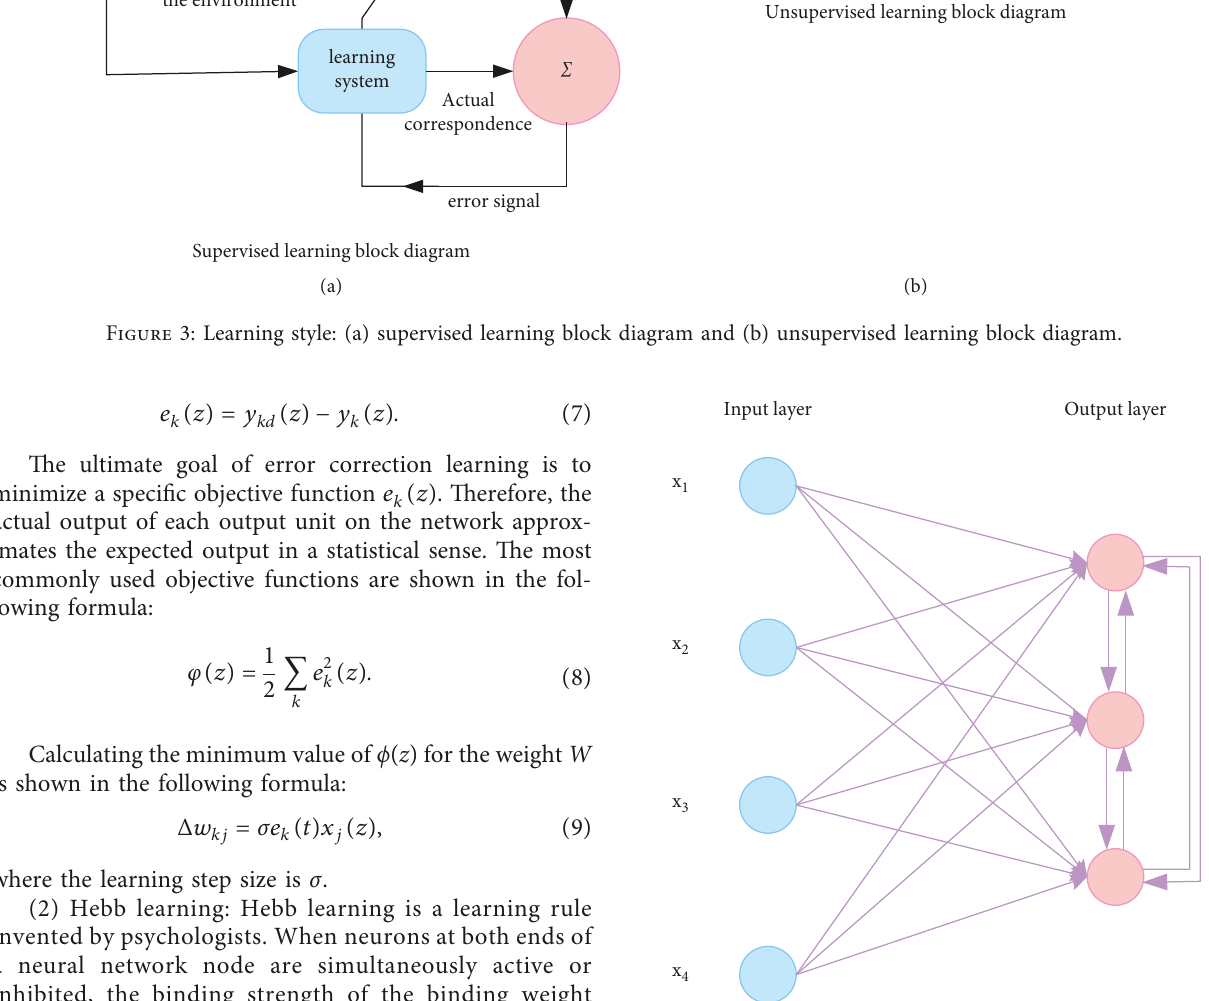
Figure 4: Competitive learning network with lateral inhibitory